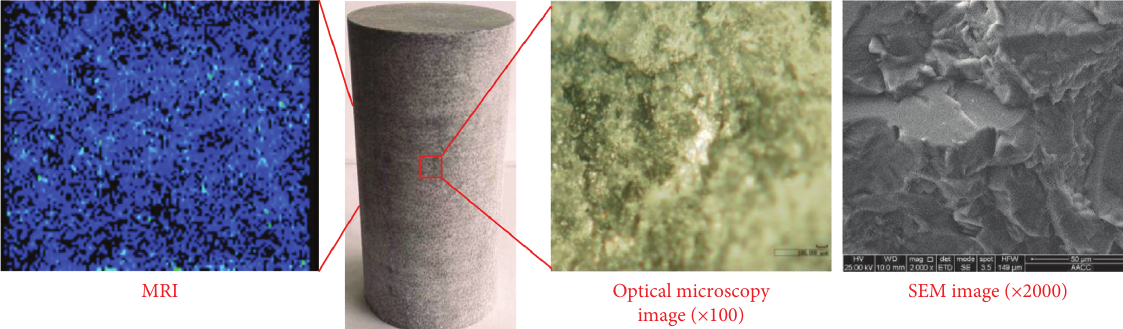
Figure 1: Microstructure of limestone.